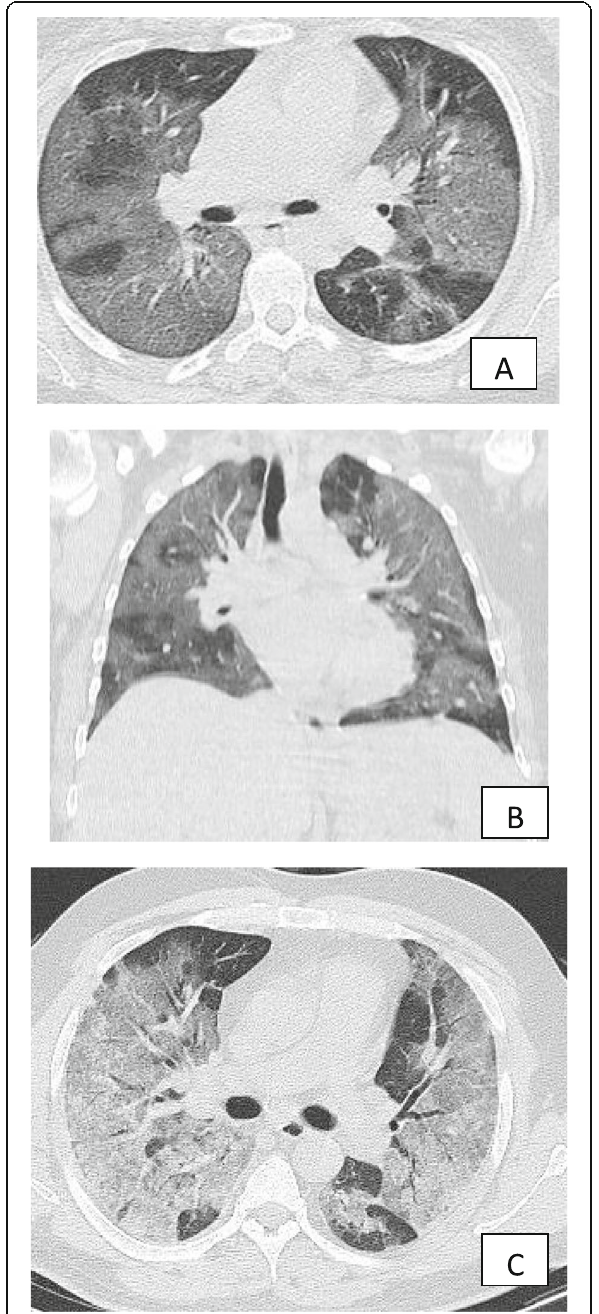
Fig. 6 Two cases of white lung. a , b Patient with ground glass infiltration diffusely affecting both lungs giving the lung white out appearance. c Another case with relatively dense ground glass infiltration and consolidation diffusely affecting both lungs with air bronchogram